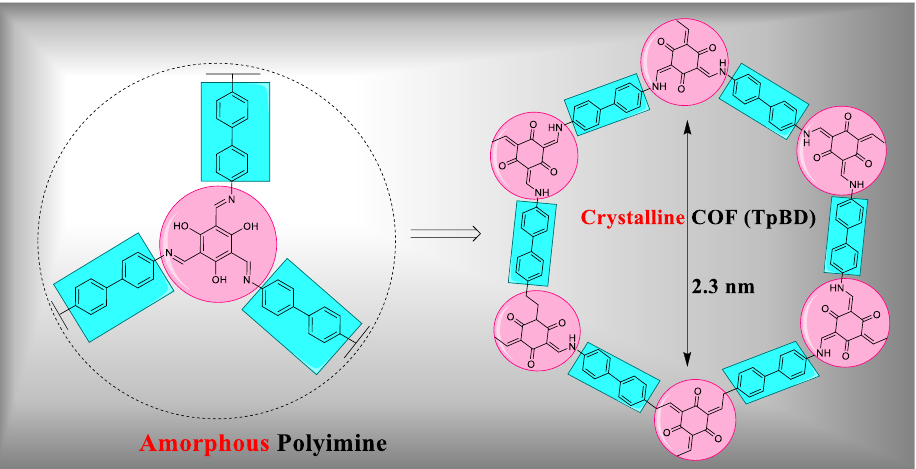
Figure 8. Basic unit (amorphous polyimine) and crystalline COF (Tpbd) “Reproduced with permission of John Wiley and Sons, Angewandte Chemie International Edition from Manipulation of amorphous-to-crystalline transformation: Towards the construction of covalent organic framework hybrid microspheres with NIR photothermal conversion ability by Tan, J.; Namuangruk, S.; Kong, W.; Kungwan, N.; Guo, J.; Wang, C. in Angew. Chem. Int. Ed. 2016, 55, 13979 – 13984 [108] ”.